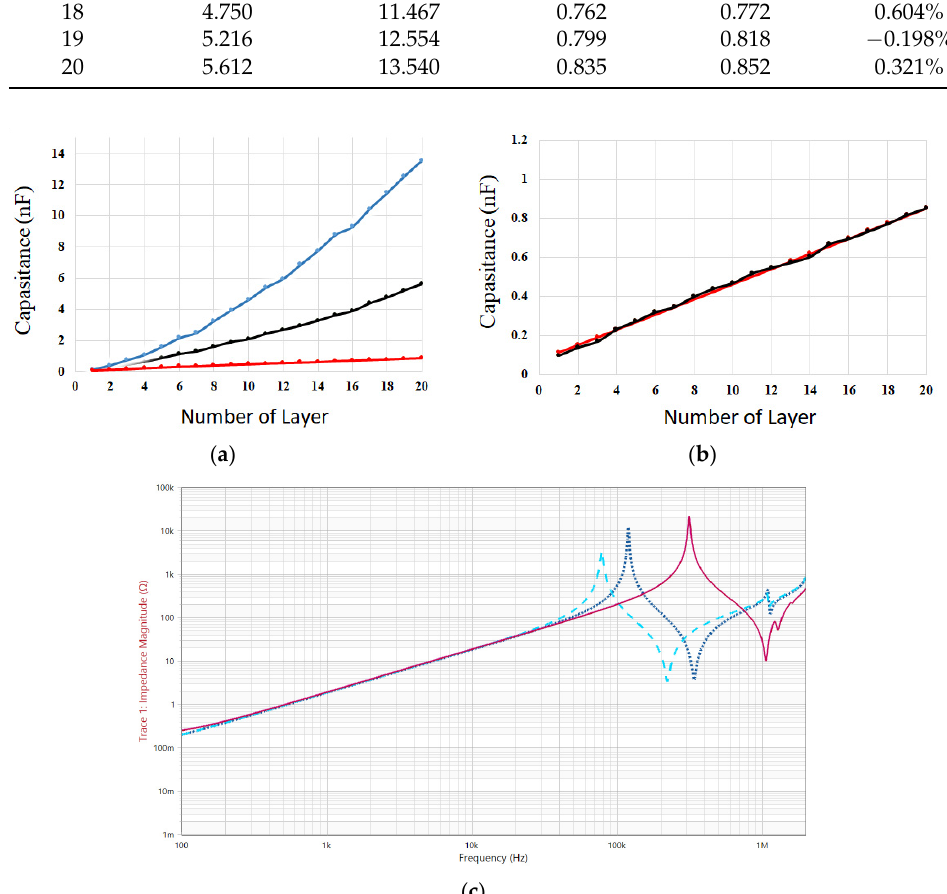
Figure 13. Capacitance measurement for TR1 and TR2: ( a ) The comparison of 𝐶 (cid:3047)(cid:3045) and 𝐶 (cid:3046)(cid:3047)(cid:3045)(cid:3028)(cid:3052) by layers (blue—TR1 𝐶 (cid:3046)(cid:3047)(cid:3045)(cid:3028)(cid:3052) , black—TR1 𝐶 (cid:3047)(cid:3045) , red—TR2 𝐶 (cid:3046)(cid:3047)(cid:3045)(cid:3028)(cid:3052) ); ( b ) The comparison of calculated and measured 𝐶 (cid:3046)(cid:3047)(cid:3045)(cid:3028)(cid:3052) for TR2 (red—calculated, black—measured); ( c ) The frequency response measurement of TR1 and TR2 for 20 layers: (dashed—TR1 𝐶 (cid:3046)(cid:3047)(cid:3045)(cid:3028)(cid:3052) , dotted—TR1 𝐶 (cid:3046)(cid:3047)(cid:3045)(cid:3028)(cid:3052) , solid—TR2). Table 3. Frequency response measurements for prototypes.